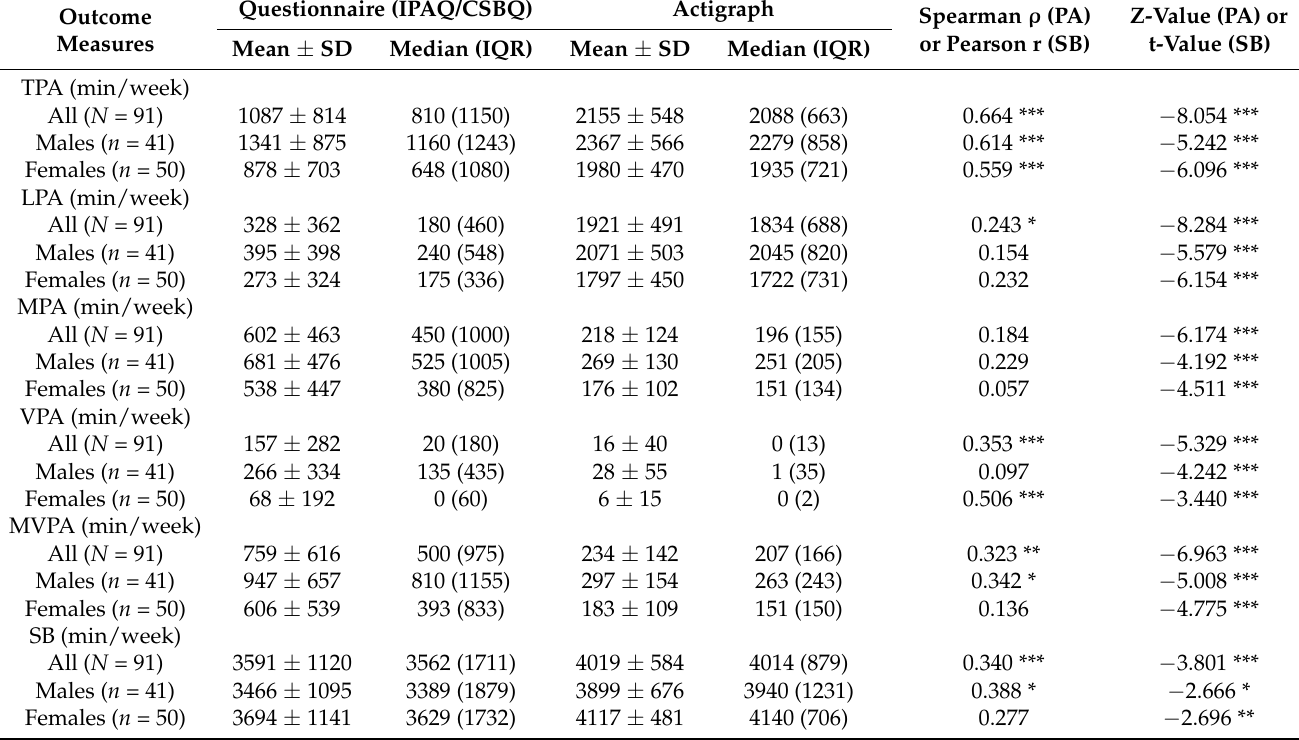
Table 2. Validity and agreement of IPAQ and CSBQ data vs. Actigraph